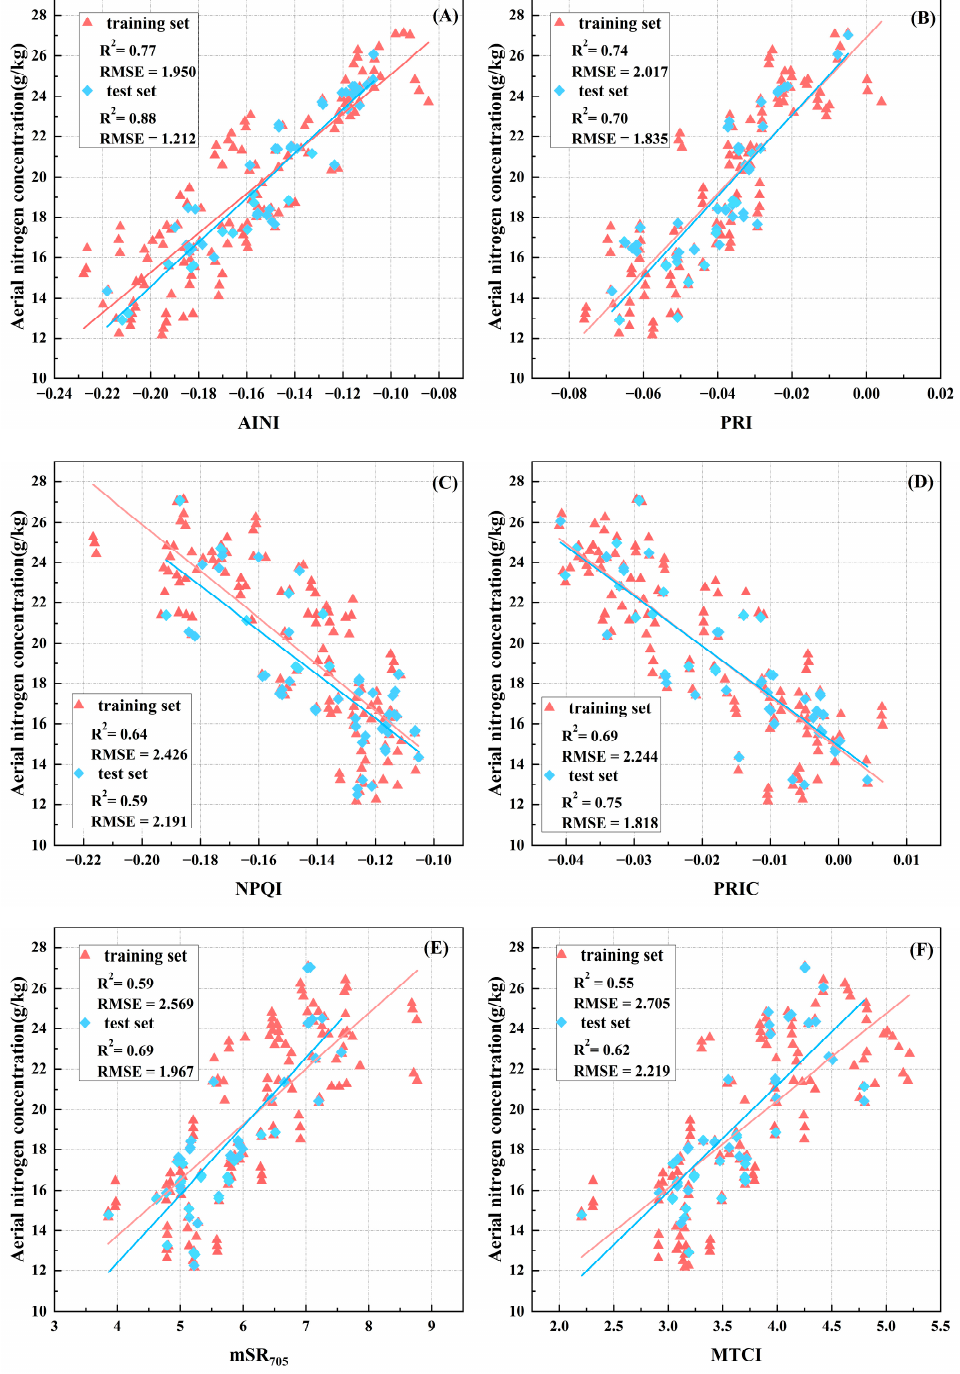
Figure 7. Linear relationship between ANC and spectral index at specific angles: ( A ) − 50° PRI, ( B ) − 50° AINI, ( C ) 40° NPQI, ( D ) 50° PRIC, ( E ) 60° mSR 705 , ( F ) 60° MTCI.